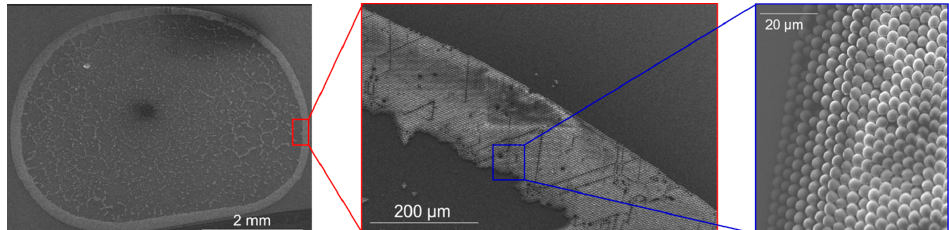
Figure 1. Typical SEM image of a cluster-ring deposit of polymethylmethacrylate (PMMA) particles arising from droplet dispensing on an n -type (100) silicon-substrate surface.